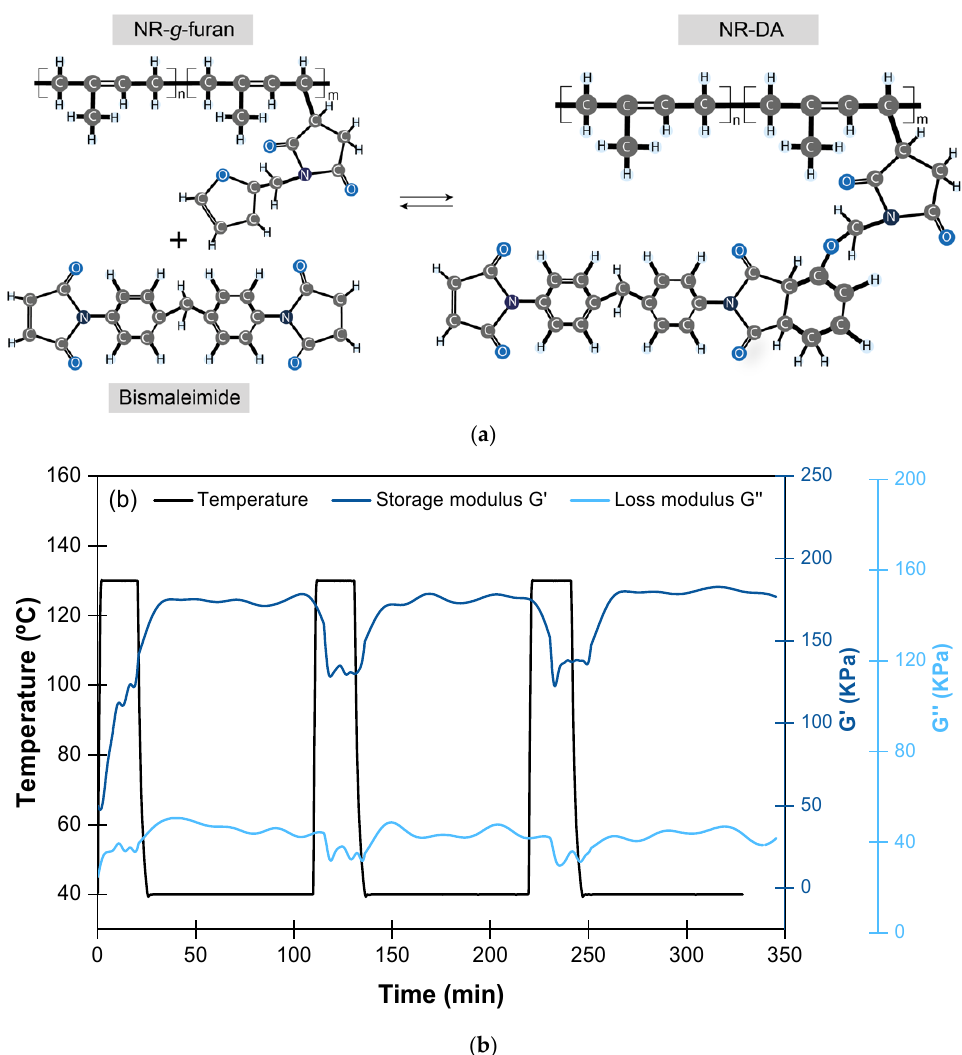
Figure 6. ( a ) DA-based crosslinked process, ( b ) dynamic character of the DA reaction evidenced by DMA. Adapted with permission from [64]. 2019, Elsevier.